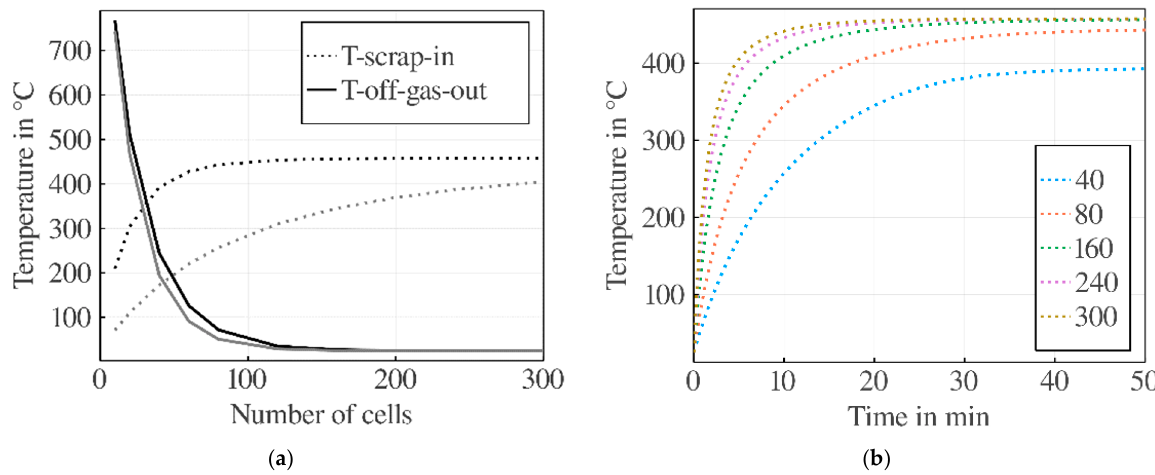
Figure 14. Scrap (S3) preheating and off-gas outlet temperature after 5 (gray lines) and 50 min (black lines) for different cell numbers ( a ); scrap (S3) preheating temperature development for cell numbers ( b ).